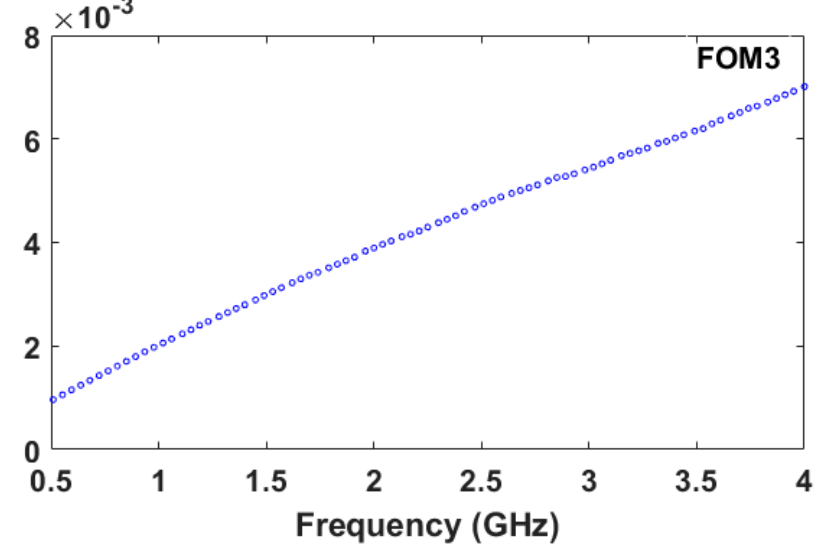
Figure 13. The FOM3 is depicted from the frequency range of 0.5–4.0 GHz.